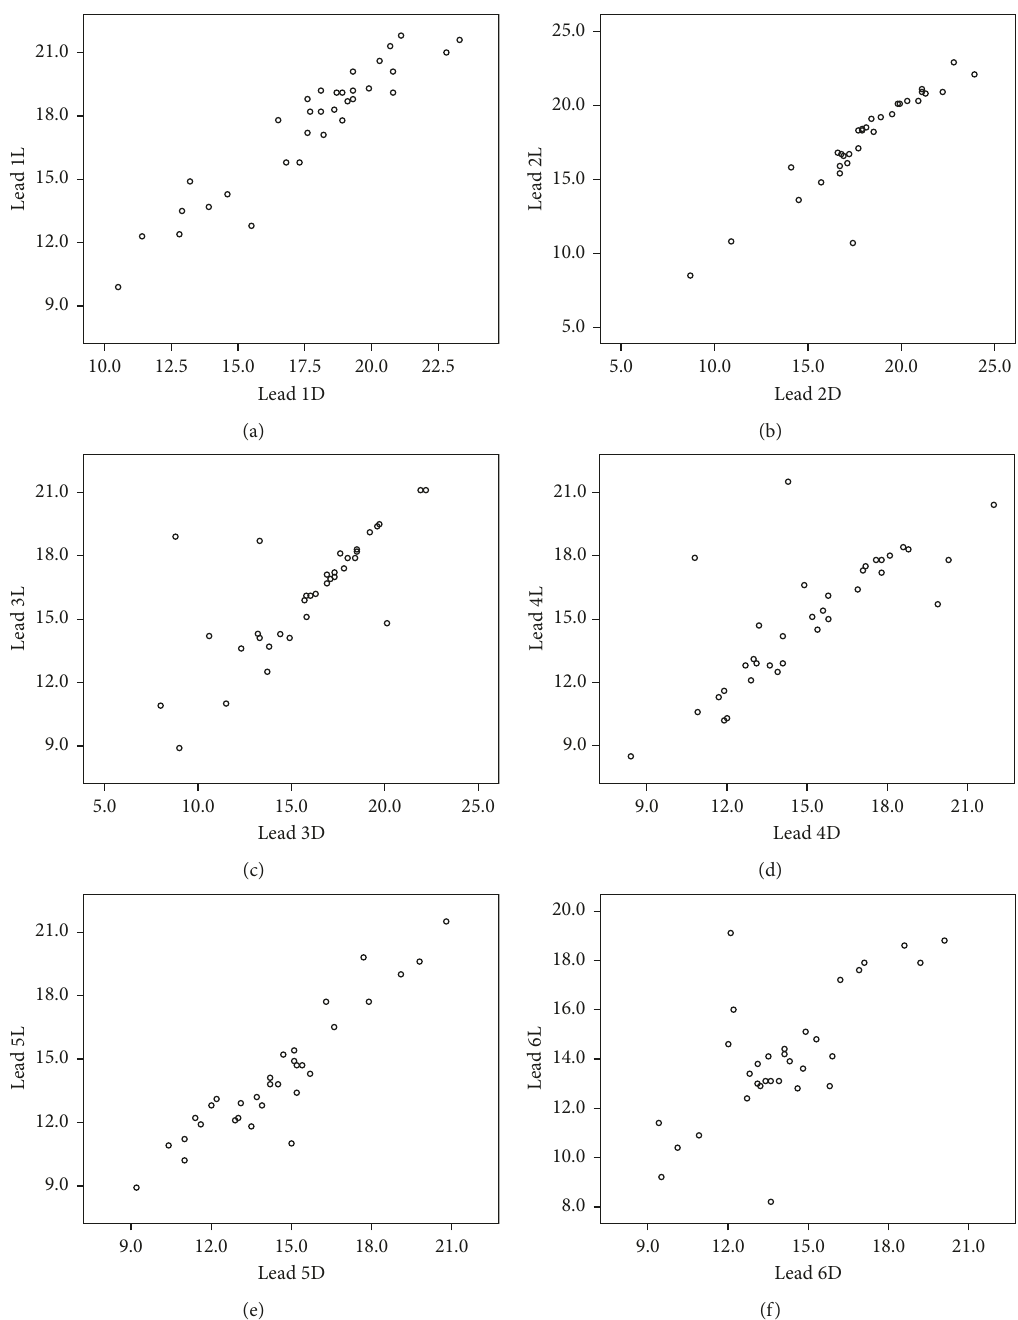
Figure 1: Scatter plots for the individual amplitudes of e-ECAP in the light and deep anesthesia in lead 1 (a), lead 2 (b), lead 3 (c), lead 4 (d), lead 5 (e), and lead 6 (f). The absolute differences showed no statistical difference. Thus, the variation is not clinically